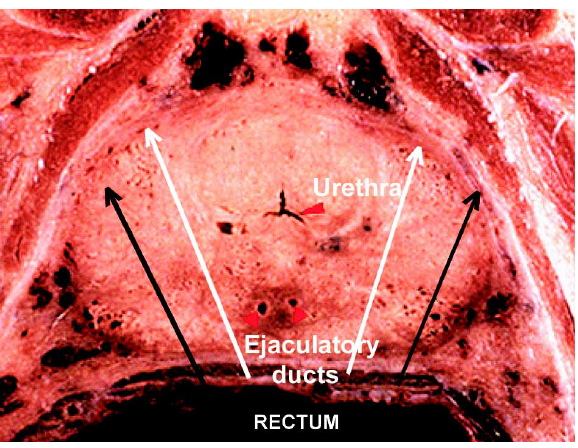
Figure 3 – Transverse section of the prostate, showing the local- ization of the punctures. Sextant punctures in white and lateral in black (authorized by